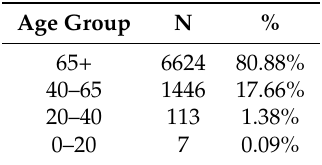
Table 3. Age groups in